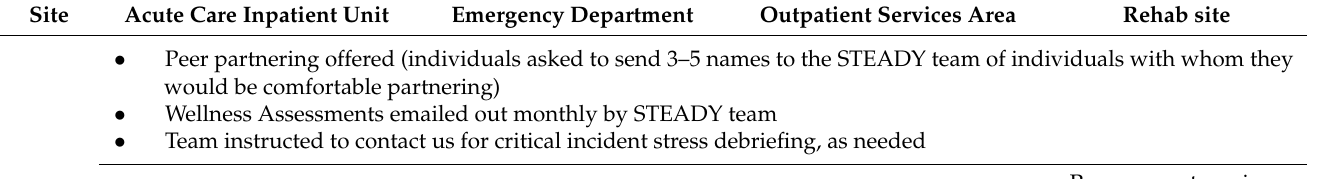
Table 2. Examples of initial implementation plans for differing units determined by STEADY team in conjunction with target group leadership and relevant